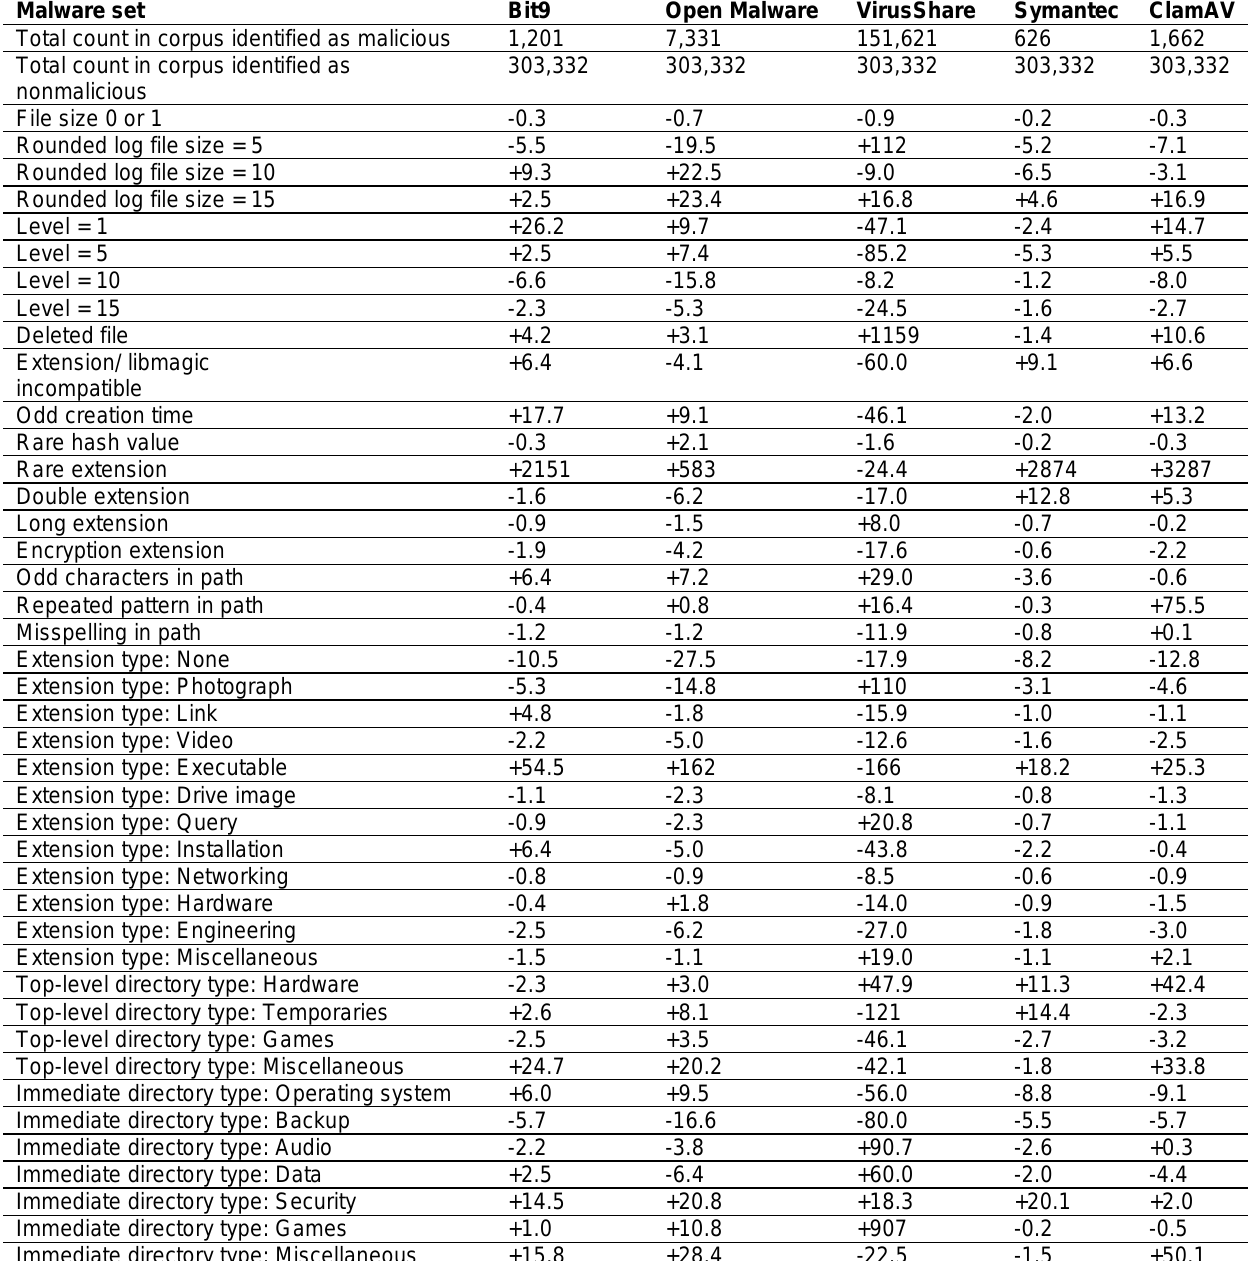
Table 1. Strengths of various malware clues, measured as number of standard deviations plus or minus of the expected random frequency, counting by hash